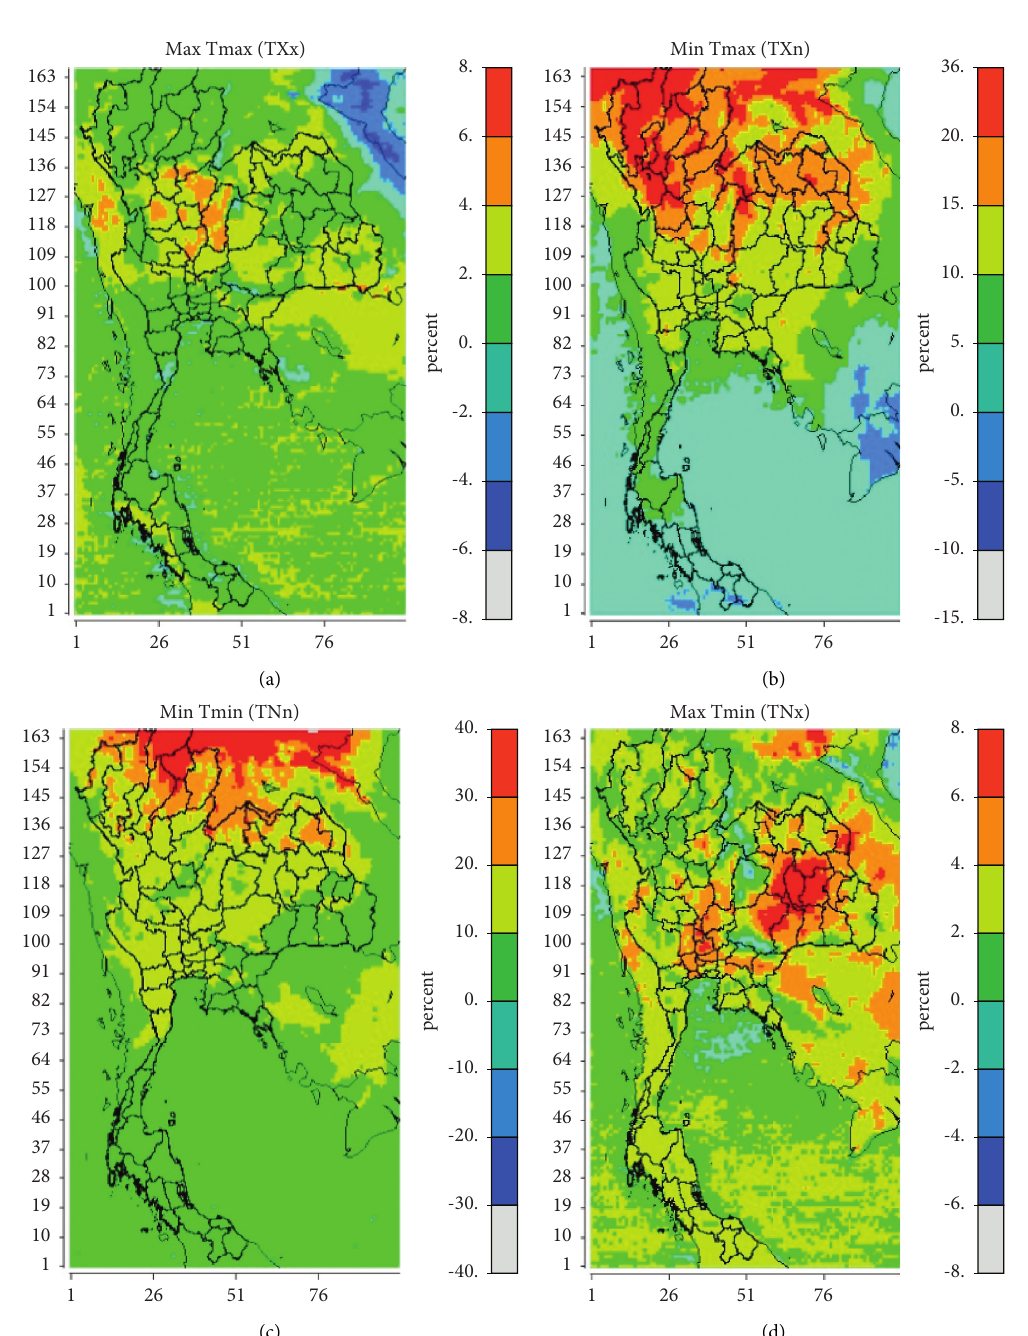
Figure 2: Spatial distribution of percentage differences in (a) TXx, (b) TXn, (c) TNn, and (d) TNx between years 2020 and 2029 and between years 1990 and 1999 in Thailand.